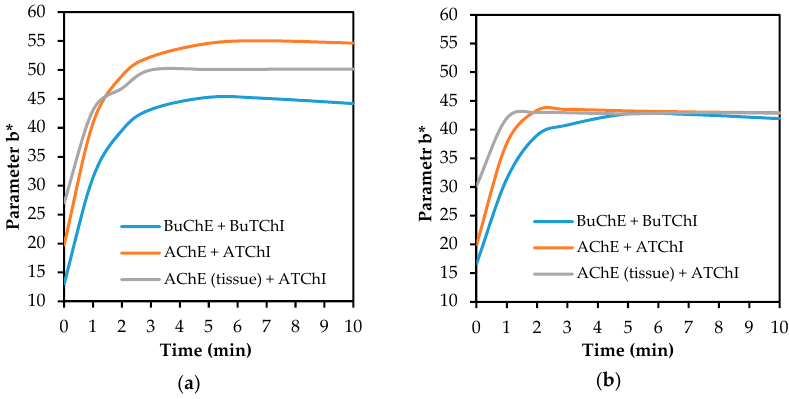
Figure 5. The development of the change in colour of the detection fabric (blank test), depending on the composition of the detection system with enzyme–substrate: ( a ) filter glass paper; ( b ) filter cellulose paper.